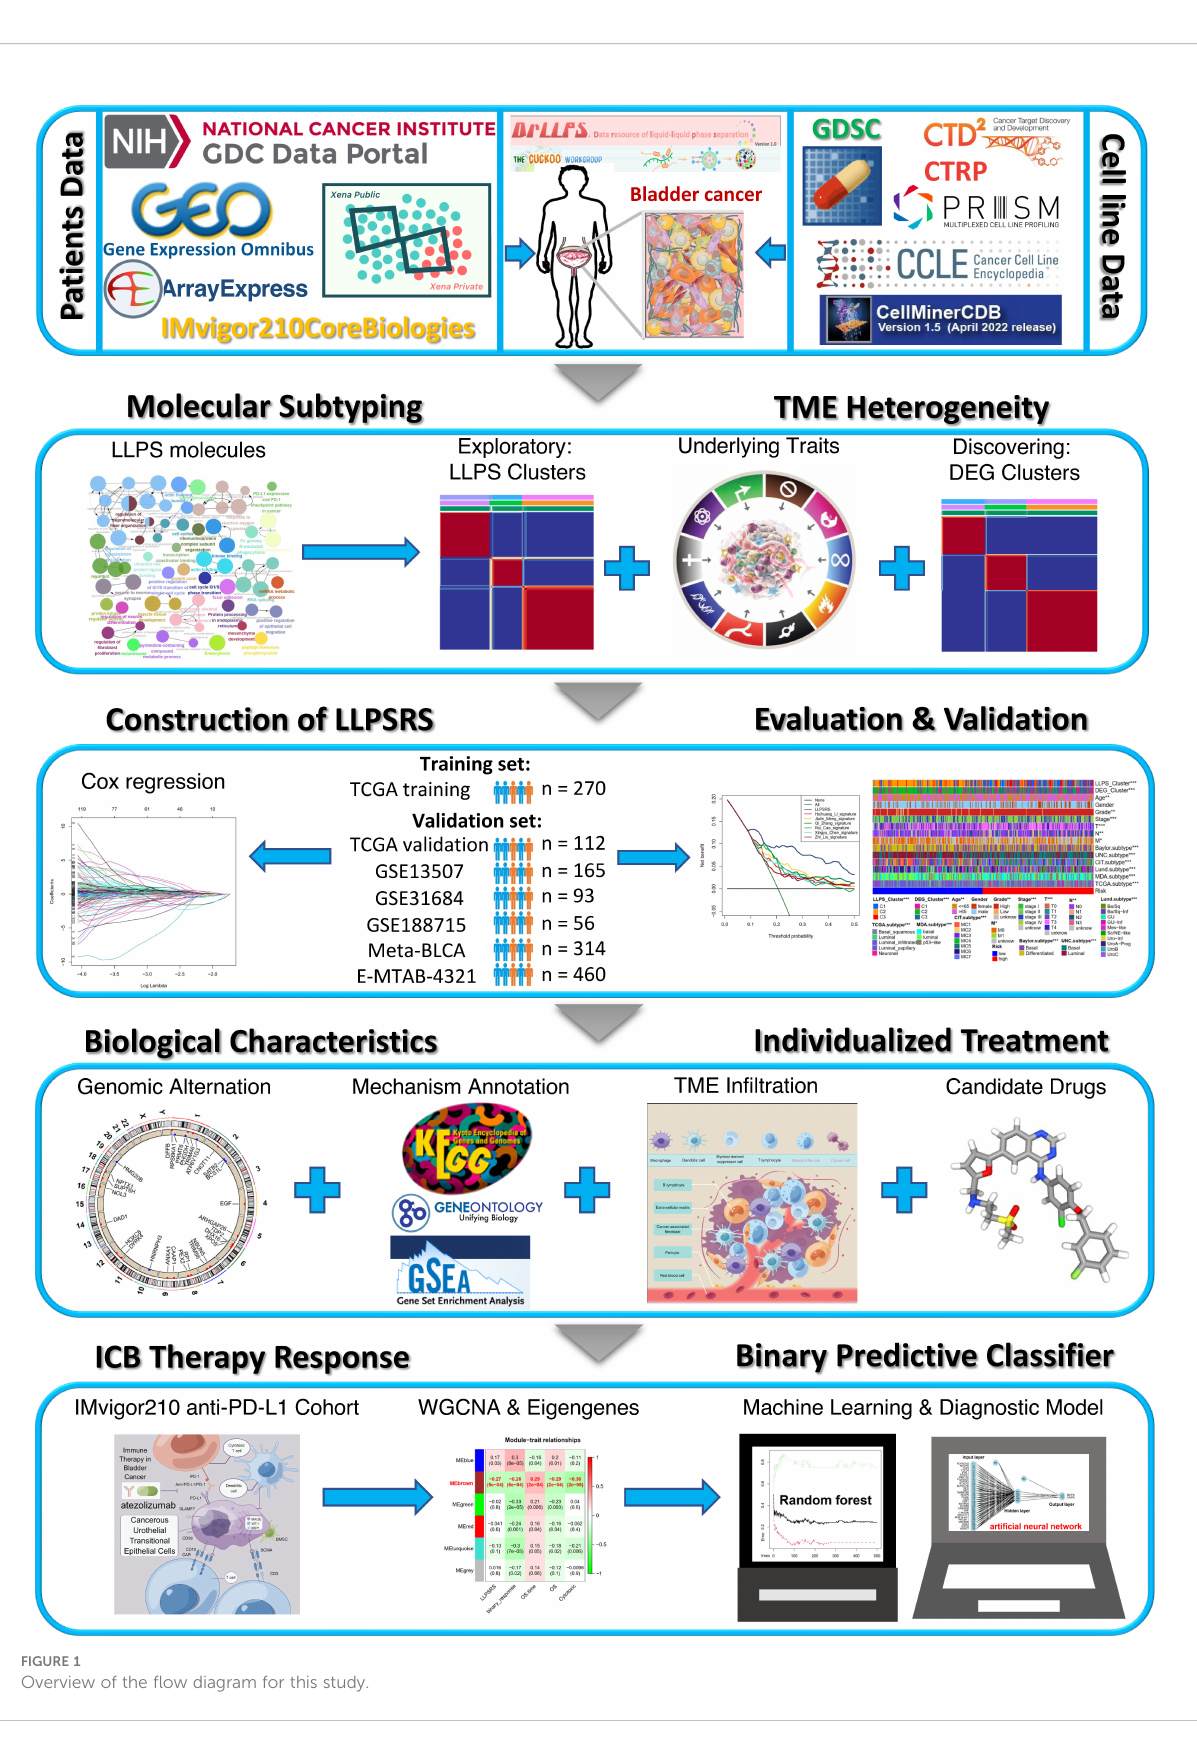
FIGURE 1 Overview of the fl ow diagram for this